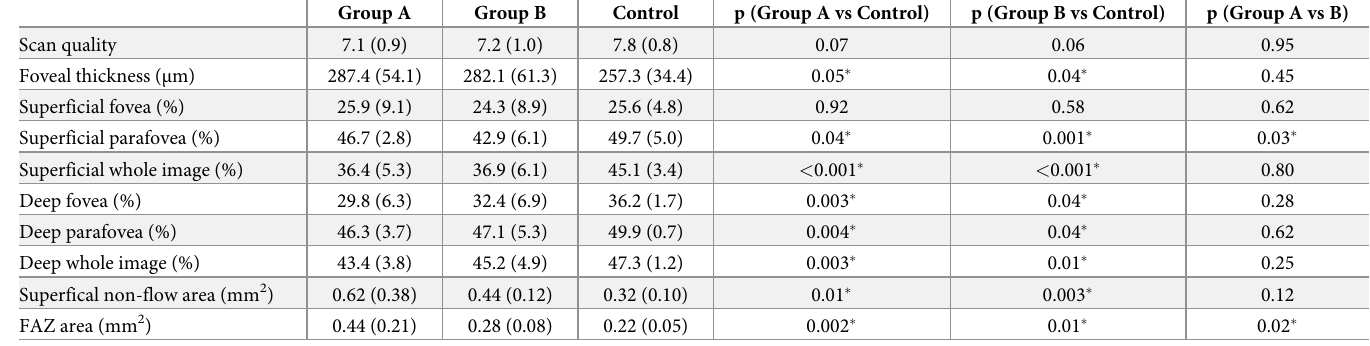
Table 2. Results of OCT-A examinations. Superficial and deep vascular density in the fovea, parafovea and in the whole image. Non-flow area and foveal avascular zone (FAZ). Data are shown as mean (SD).